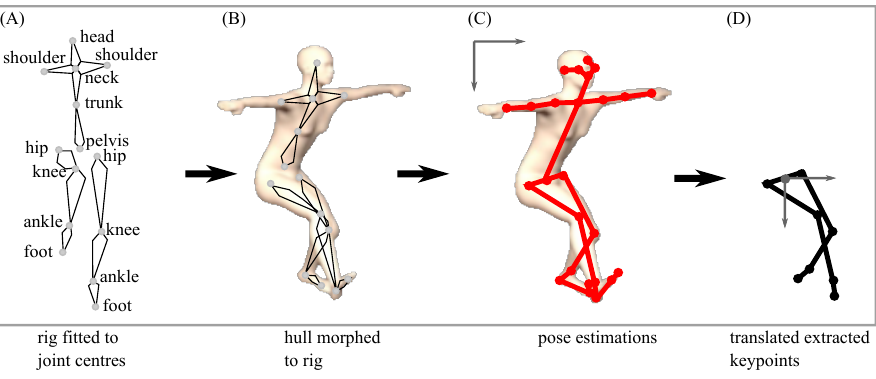
Figure 4. ( A ) A 3D animation rig was fitted to body segment and joint centres calculated from the participant-specific 3D motion capture static trial data. ( B ) A female 3D hull was morphed to the rig, and ( C ) 25 anatomical/segment 2D OpenPose keypoints were estimated. The arms of the 3D hull remained in a fixed neutral T-pose posture as the fitted rig did not contain arms due to the absence of arm 3D markers. ( D ) Eight lower limb keypoints identified by OpenPose, which returned a high detection rate, were extracted and translated to a moving pelvis coordinate